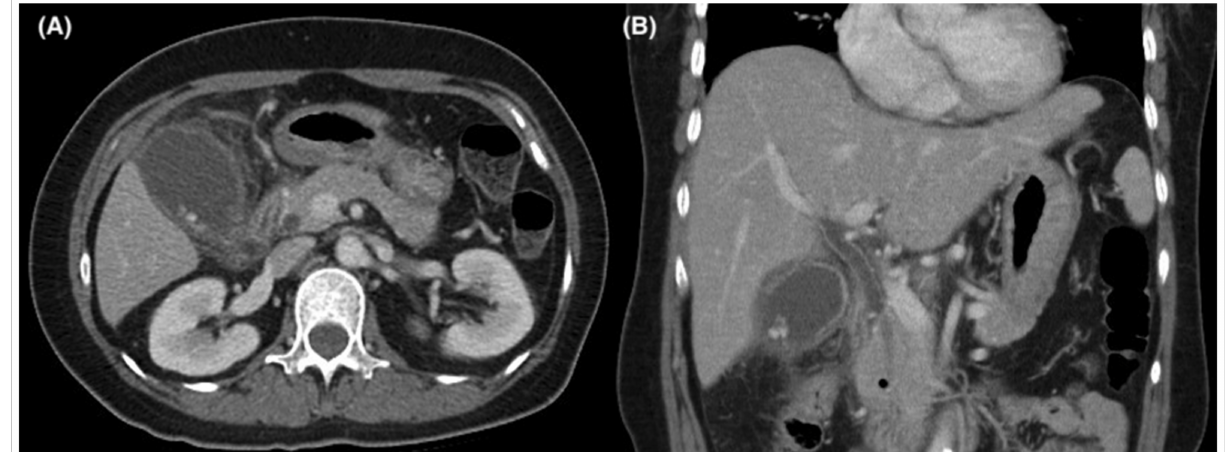
Figure 1. Axial ( A ) and coronal ( B ) computed tomography images of a patient with concurrent acute cholecystitis and